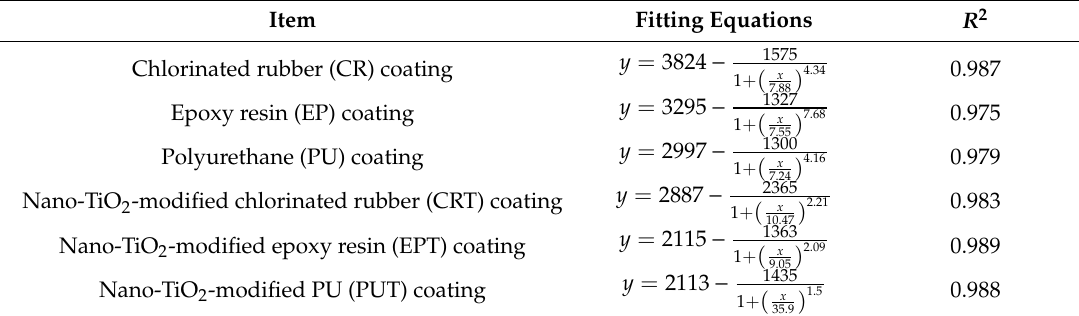
Table 1. Fitting equations of coated concrete with ultraviolet